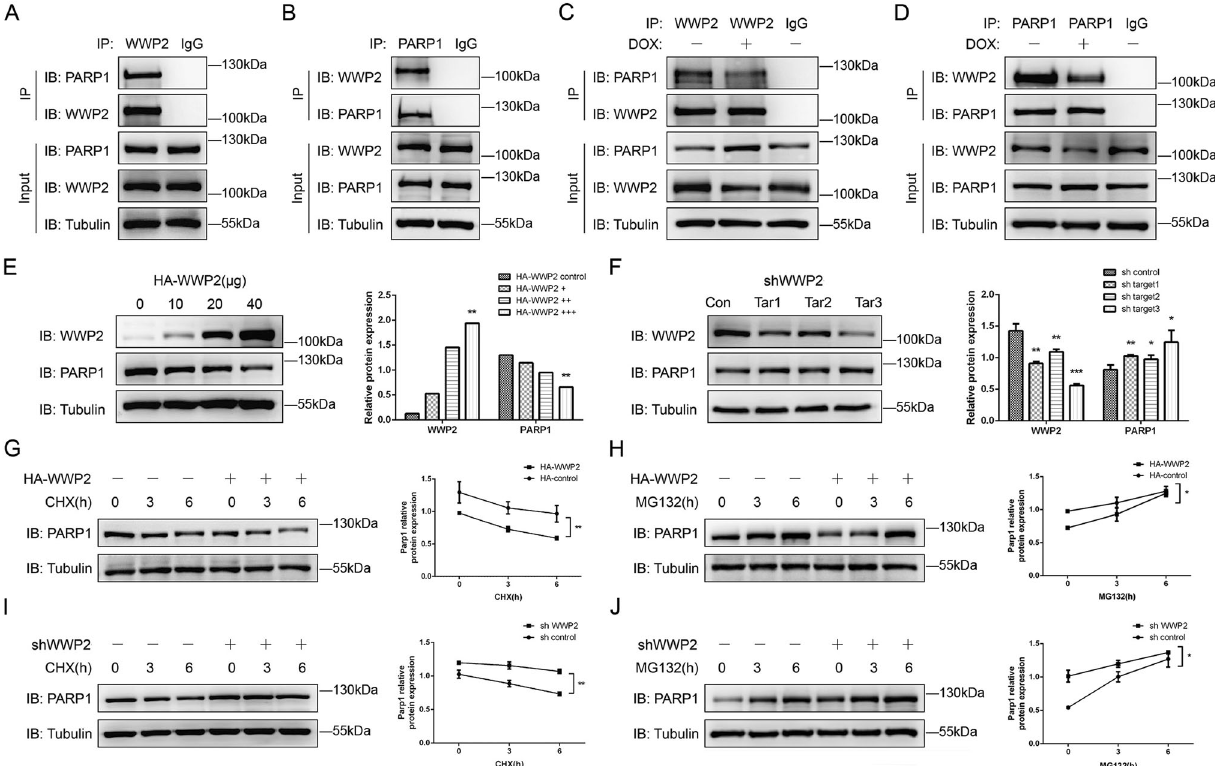
Fig. 4 WWP2 interacts with PARP1 and negatively regulates PARP1 through proteosome degradation. A , B Coimmunoprecipitation assays were performed to assess bidirectional interaction between WWP2 and PARP1. C , D Coimmunoprecipitation assays were performed to assess bidirectional interaction between WWP2 and PARP1 under normal condition and stimulation of Dox (0.2 μ M). E Western blot was carried out to assess PARP1 expression level with overexpression of WWP2 gradually. Data were shown as mean ± SD (* p < 0.05, ** p < 0.01; one-way ANOVA with Bonferroni ’ s post-hoc test). F Western blot was carried out to assess the ef fi ciency of WWP2 knockdown by three target shRNA-WWP2 and the expression of PARP1 in Jurkat cells. Data were shown as mean ± SD (* p < 0.05, ** p < 0.01, *** p < 0.001; unpaired Student ’ s t test). G – J Western blot was performed to assess PARP1 expression in Jurkat cells with WWP2 overexpression under different durations of CHX ( G ) or MG132 ( H ), and PARP1 expression in Jurkat cells with WWP2 knockout under different durations of CHX (I) or MG132 ( J ). Data were shown as mean ± SD (* p < 0.05, ** p < 0.01; two-way ANOVA with Bonferroni ’ s post-hoc